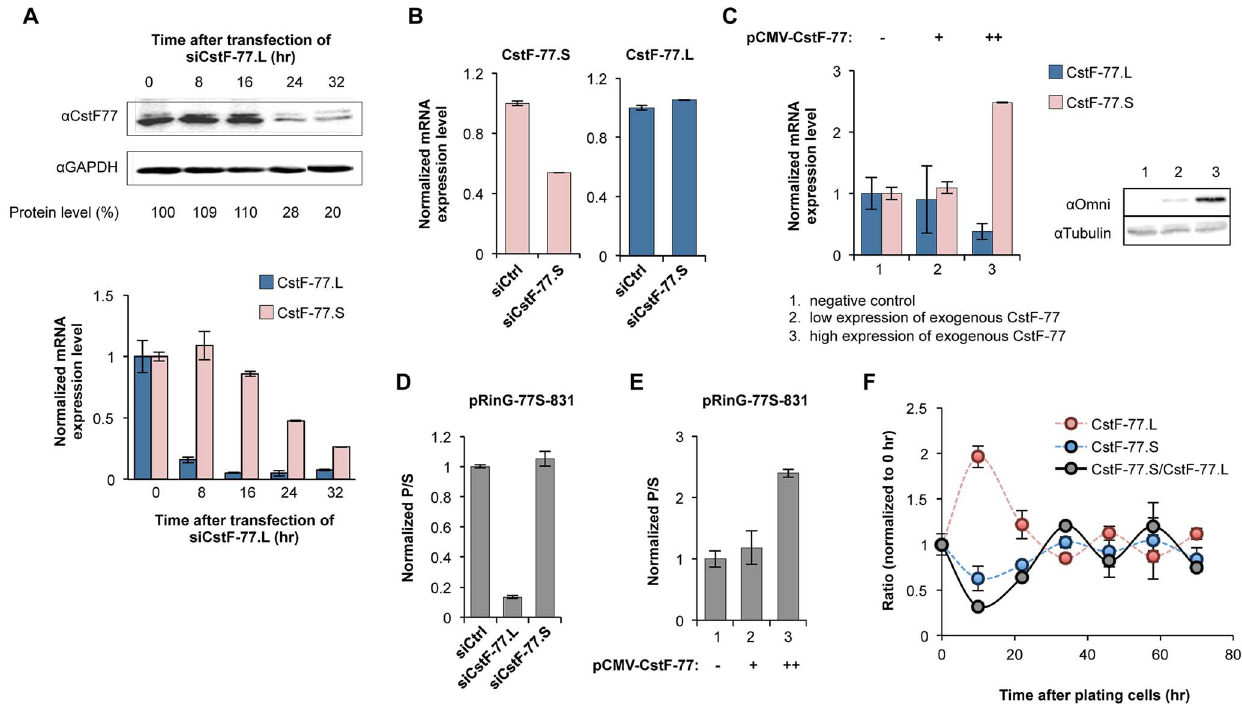
Figure 3. The intronic pA of CSTF3 is involved in feedback autoregulation. ( A ) Effect of CstF-77 knockdown by siRNA on expression of CstF- 77.L and CstF-77.S mRNAs. Top, time course of the protein level of CstF-77 after knockdown measured by Immunoblot (IB). Data were first normalized to GAPDH and then to the time 0 hr, as indicated below the image. Bottom, the effect of CstF-77 knockdown on the expression of CstF-77.L and CstF- 77.S mRNAs. The time points are the same as those in (A). ( B ) Effect of CstF-77.S knockdown on expression of CstF-77.L. Left, knockdown of CstF-77.S as verified by qRT-PCR (both isoforms 2 and 3 are measured); right, effect of CstF-77.S knockdown on the expression of CstF-77.L. ( C ) Left, effect of CstF-77 overexpression on the expression of endogenous CstF-77.L and CstF-77.S mRNAs. Right, overexpression of exogenous CstF-77 as verified by IB using an antibody against the Omni tag of exogenous CstF-77. ( D ) Effect of CstF-77.L and CstF-77.S knockdowns on the P/S ratio of transcripts expressed from the reporter plasmid pRinG-77S-831. ( E ) Effect of CstF-77 overexpression on the P/S ratio of transcripts expressed from the reporter plasmid pRinG-77S-831. The expression levels of exogenous CstF-77 are the same as those in (C). ( F ) Time course for expression of endogenous CstF- 77.L and CstF-77.S mRNAs and the CstF-77.S/CstF-77.L ratio after plating cells. All values were normalized to those at the 0 hr. All data on mRNA expression were based on RT-qPCR.